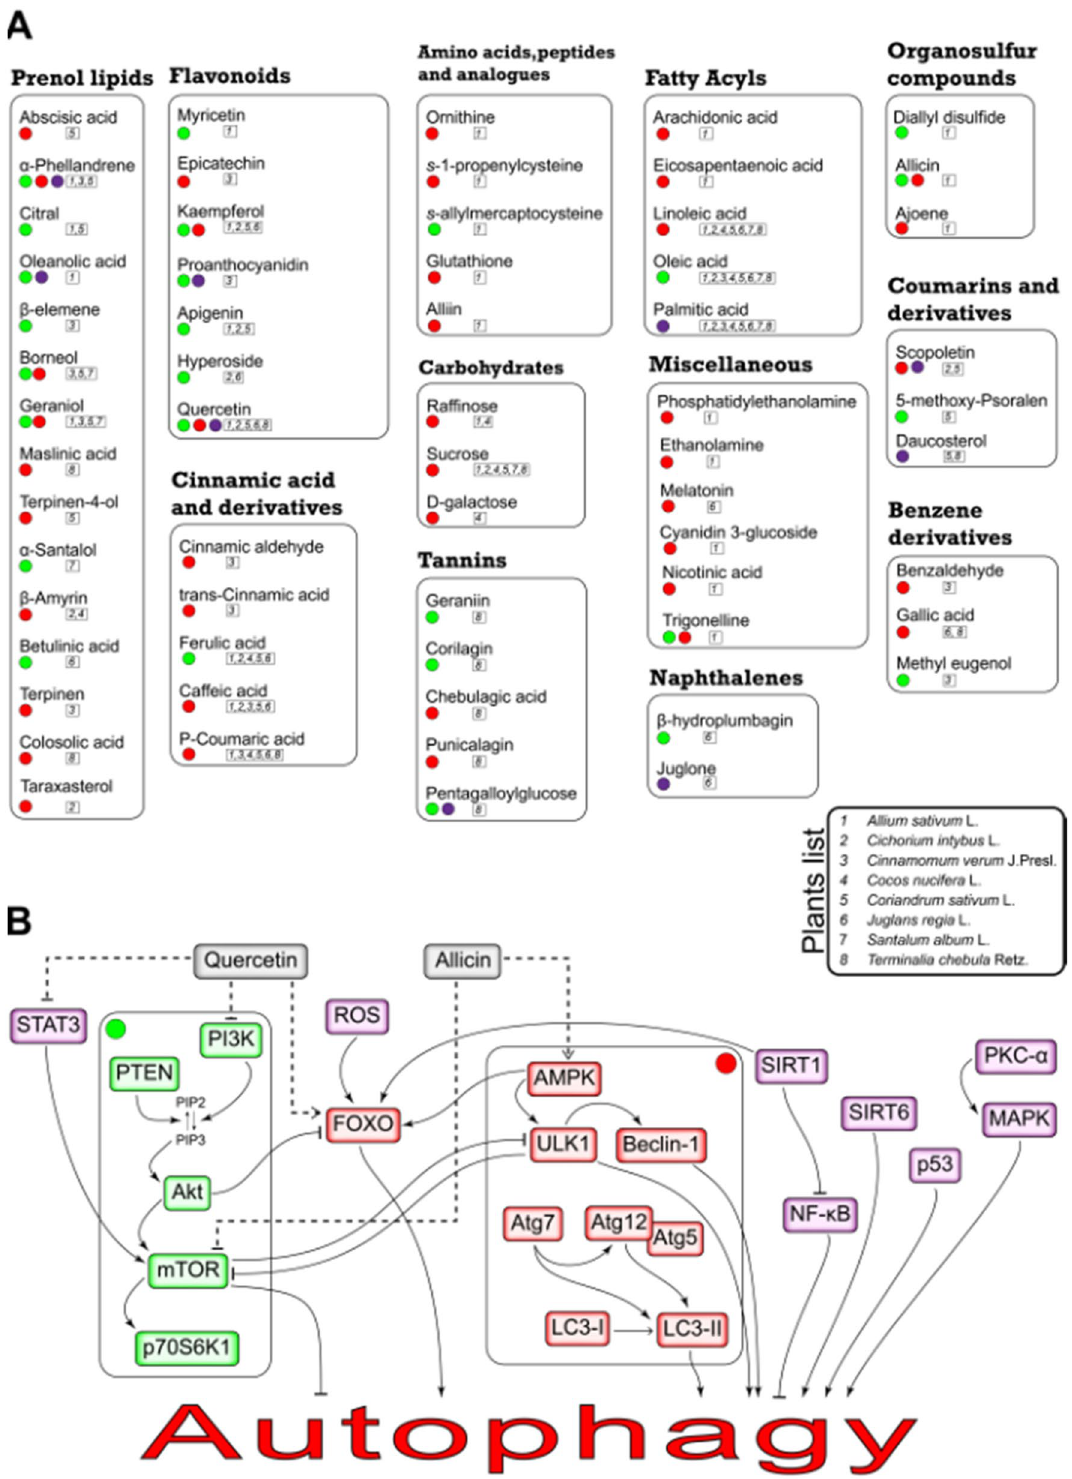
Figure 2. The schematic molecular mechanism of Autophagy-inducing effects of TPM-related phytochemicals ( A ) Each phytochemical comes with the number and colored circle, representing its related plant and mechanism of action, respectively. For instance, Allicin, a compound found in Allium sativum L., is represented by 1 and could induce autophagy by activating AMPK(red circle) and inhibiting mTOR(green circle). ( B ) Herbal medicines could modulate the key regulators of autophagy. The targets of phytochemicals were categorized into 3 groups (green, red, purple). The precise autophagy inducing effect of each phytochemical is also represented in Supplementary Table S5